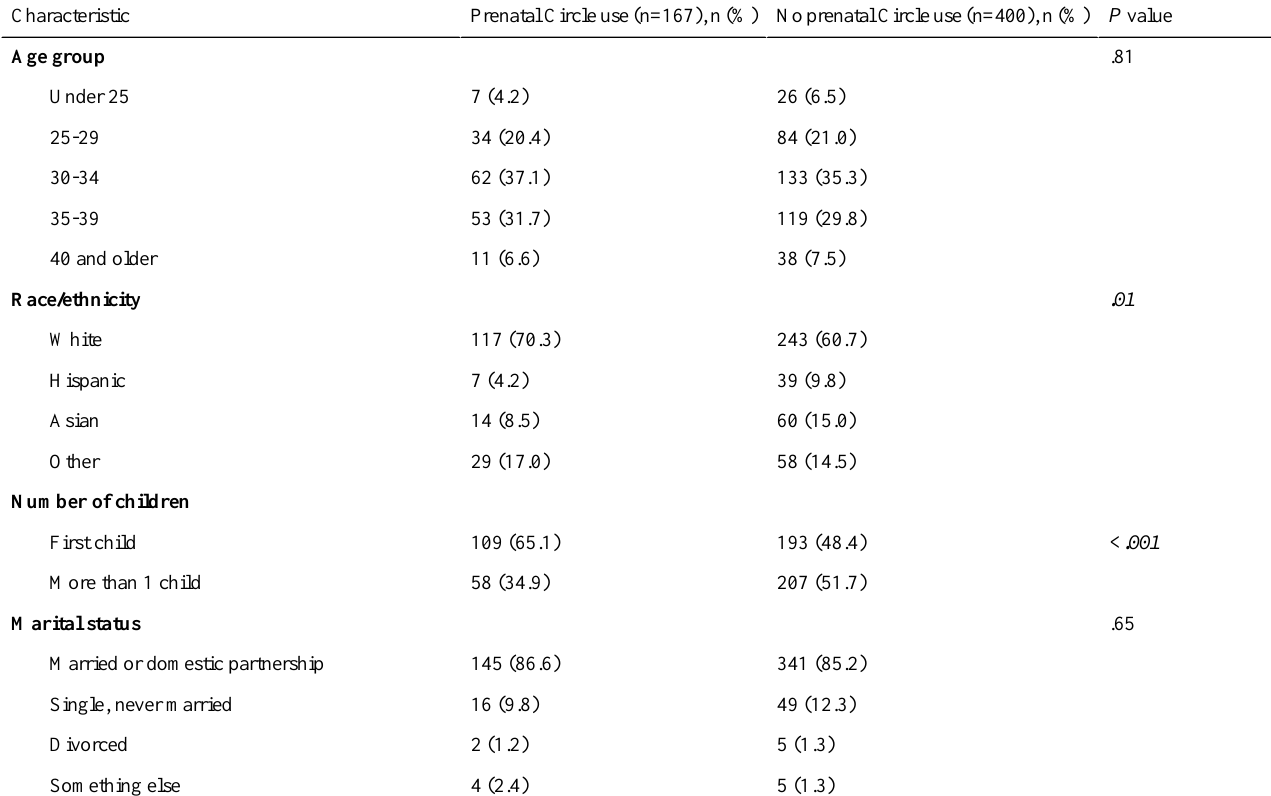
Table 1. Demographic profile of study participants (N=567). Italicized P values are significant.